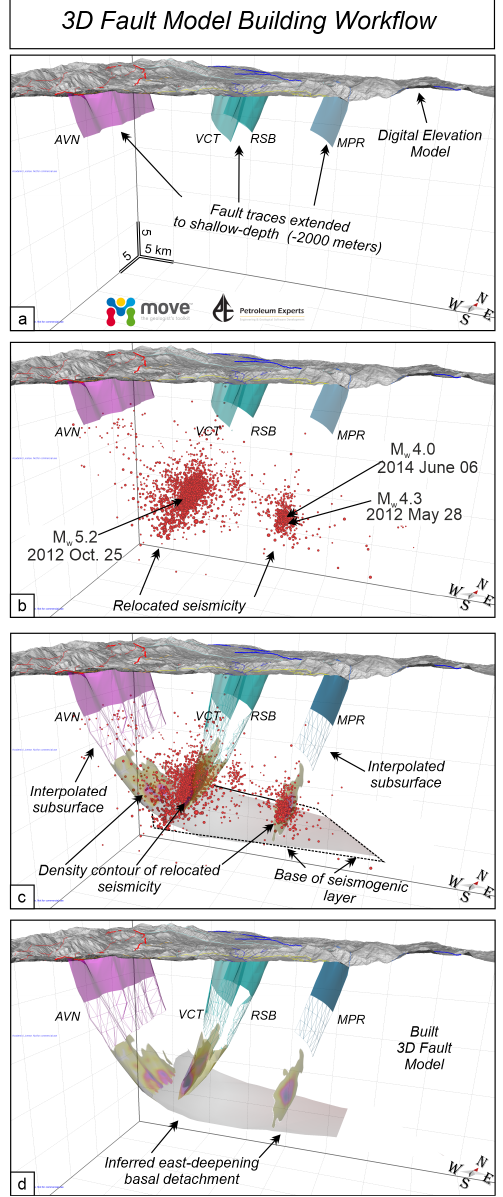
Figure 7. 3D fault model building, from the surface (10m resolu- tion DEM from Tarquini et al., 2012) to the base of the seismogenic layer. Fault acronyms as in Fig. 2. (a) “Fault ribbons” obtained by extruding the fault traces mapped at the surface down to 2km depth and considering the fault dip angles measured in the field. (b) 3D fault model as in (a) with the relocated seismicity. (c) Fault extrap- olation at (seismogenic) depth through the clusters of hypocenters; the modeled faults connect the ribbons with the zones at the depth where concentrations of hypocenters are higher. The density con- tours of the seismicity and the base of the seismogenic layer are also shown (see also d ). (d) Final 3D fault model obtained inte- grating the detailed Quaternary fault pattern with the high-quality 2010–2018 seismicity